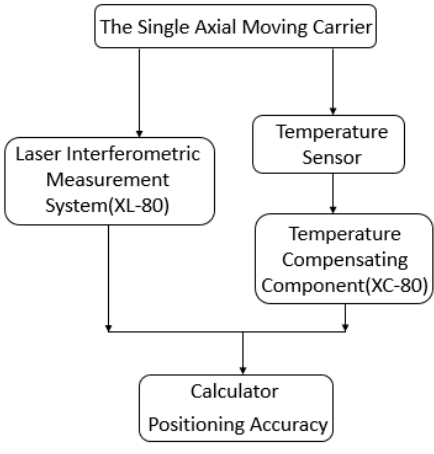
Figure 4. Schematic diagram of a laser optic measurement system [24].